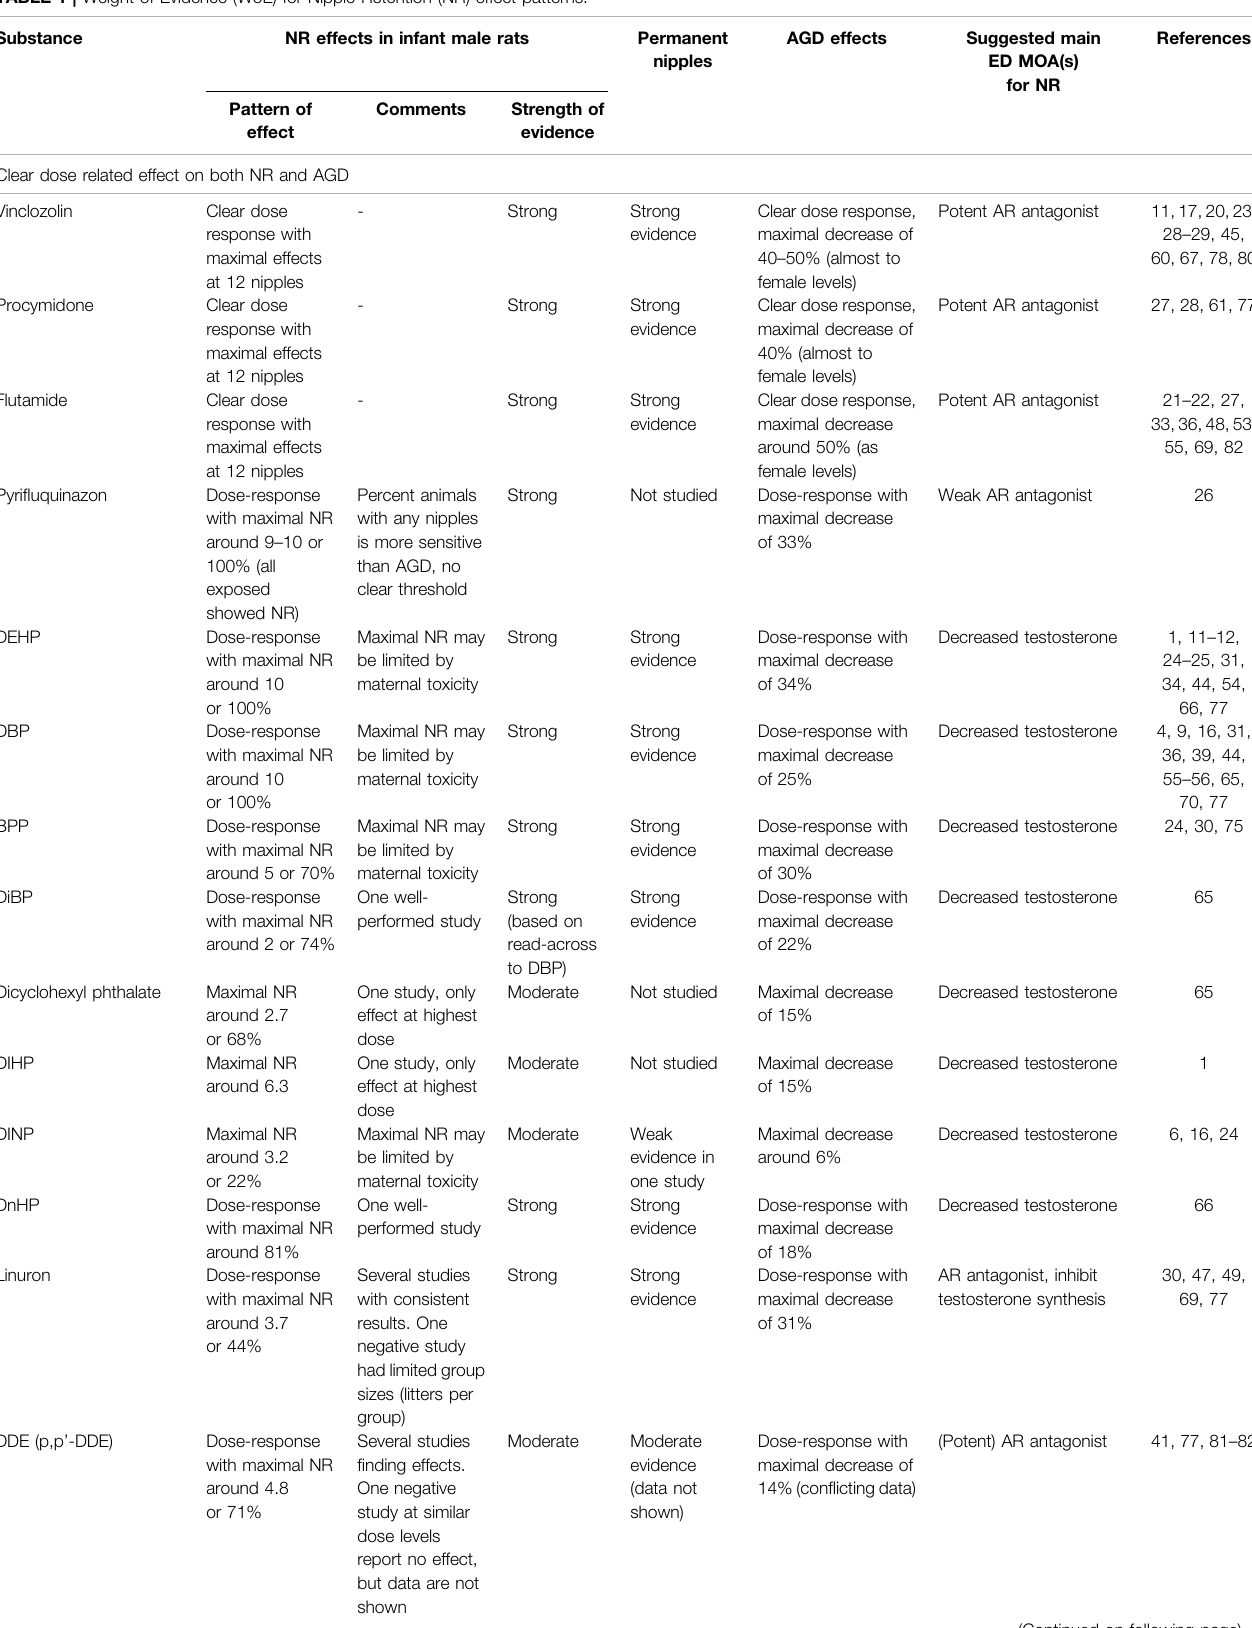
TABLE 1 | Weight of Evidence (WoE) for Nipple Retention (NR) effect